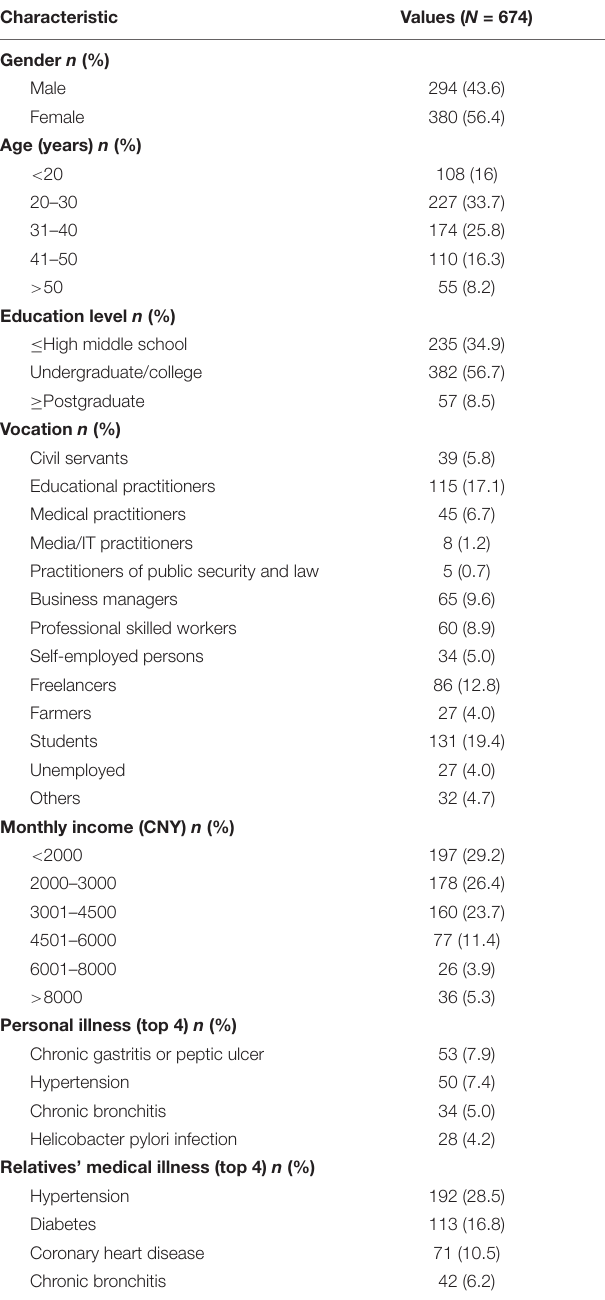
TABLE 1 | Sociodemographic and health information characteristics of participants.